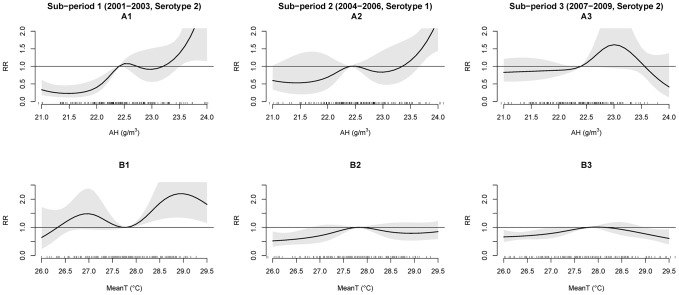
Effect of AH and MeanT on RR of dengue incidence obtained from the distributed lag model for each sub-period.A1–A3: Effect of 0–16 weeks lag of AH; B1–B3: Effect of 0–9 weeks lag of MeanT. The grey region indicates 95% CI of fitted RR. Reference AH = 22.4 g/m3 and MeanT = 27.8°C.